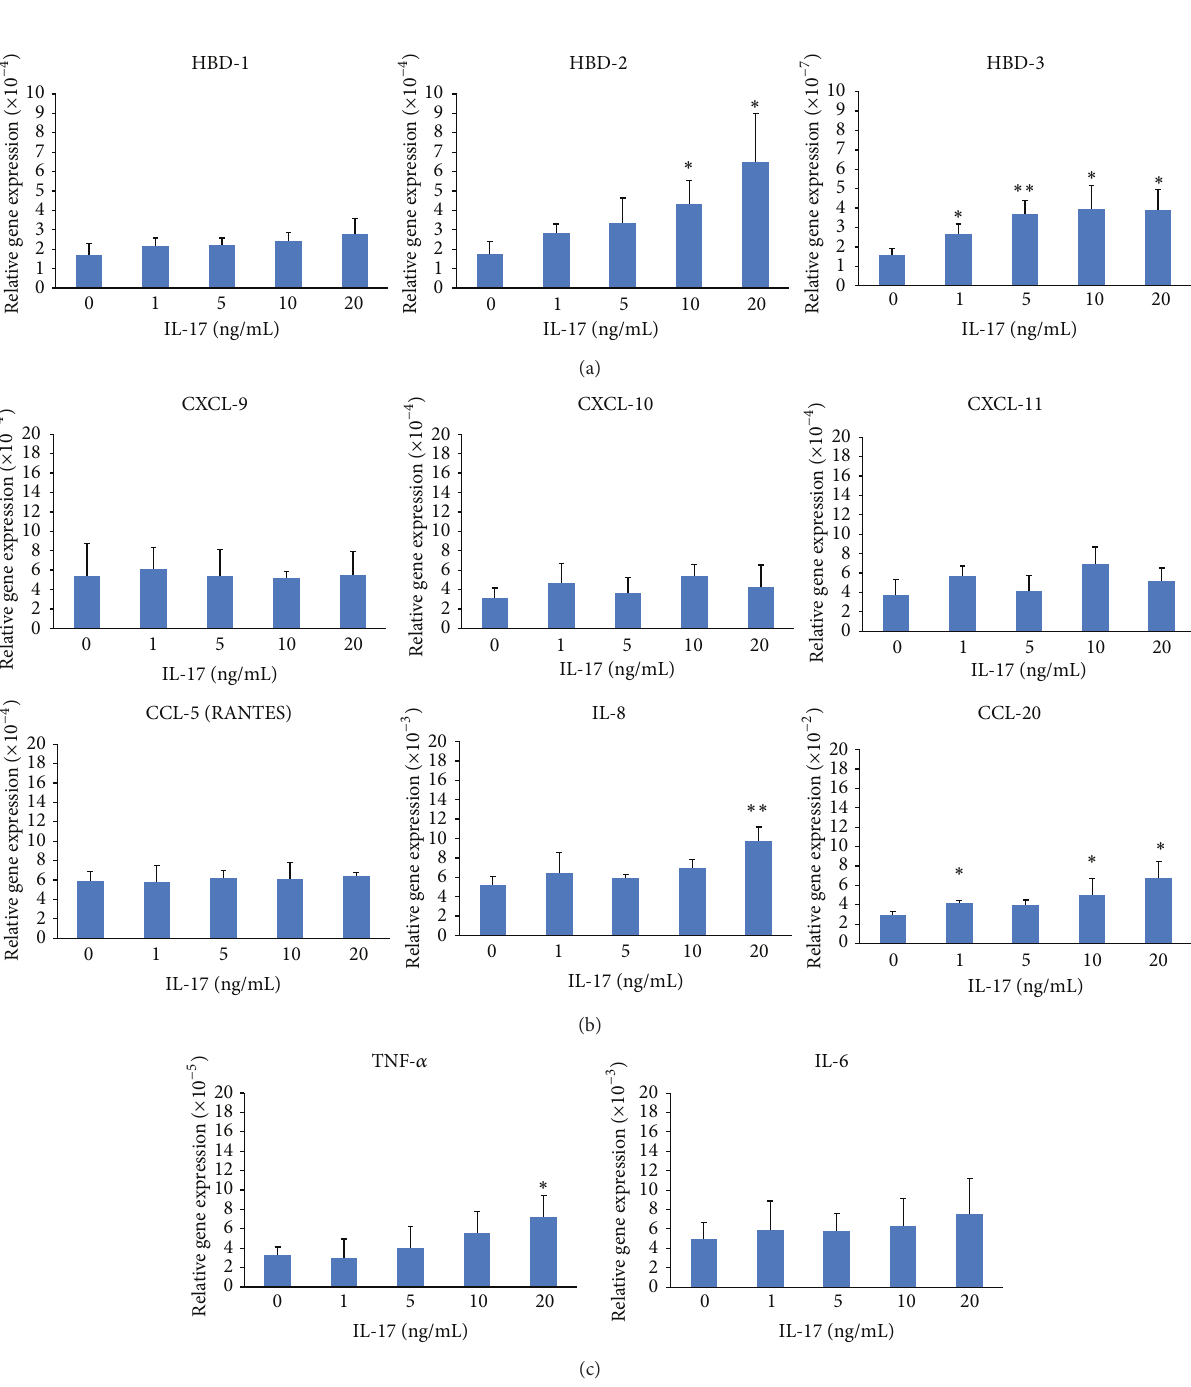
Figure 5: The effect of recombinant (r) IL-17 to the mRNA expressions of inflammatory mediators, including 𝛽 -defensins (a), chemokines (b), and proinflammatory cytokines (c), on the HOK cells. Results were shown as mean ± SEM. ∗∗ 𝑃 < 0.01 ; ∗∗ 𝑃 < 0.05